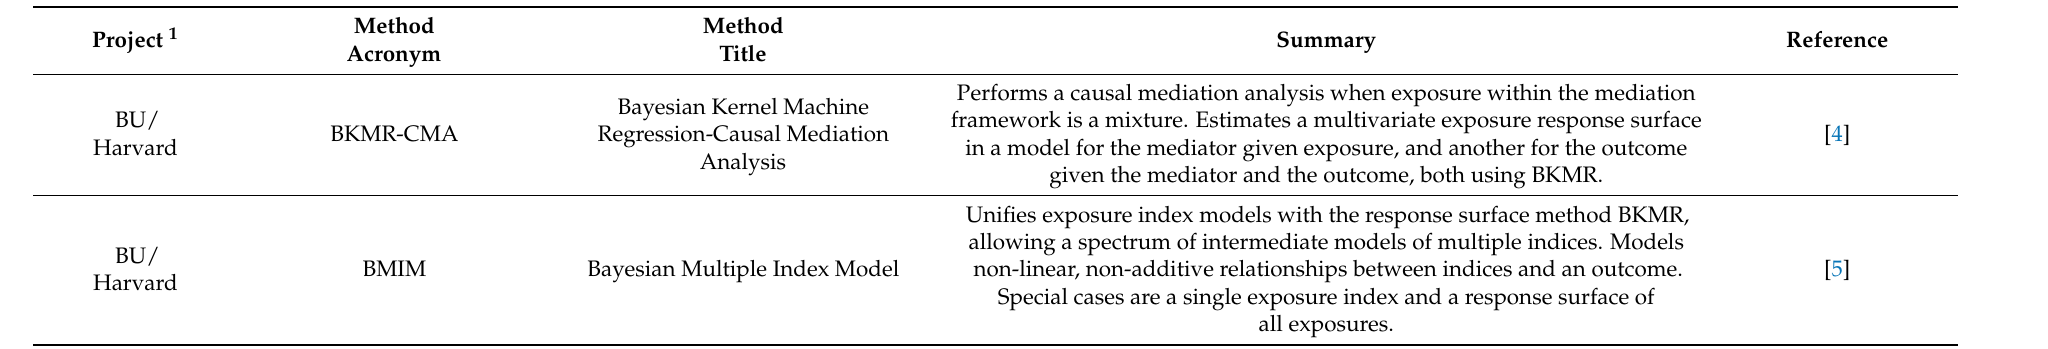
Table 2. PRIME Methods and